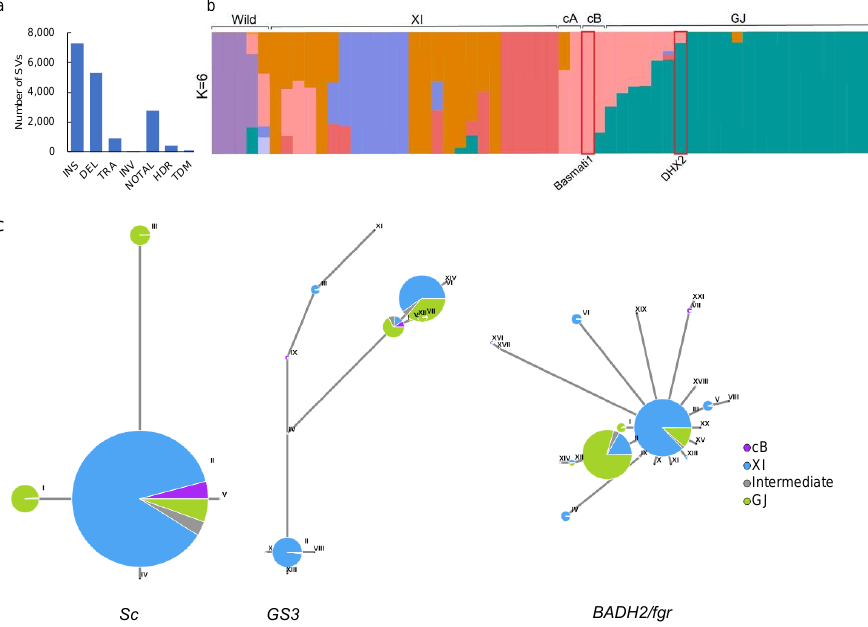
Figure 4. The population structure analysis of 58 assemblies. ( a ) The different types of SVs between DHX2 and Nip. INS: insertion, DEL: deletion, TRA: translocation, INV: inversion, NOTAL: not aligned region, TDM: tandem repeat, HDR: highly diverged regions; ( b ) Structure analysis of 58 accessions with different numbers of clusters, K = 6. The different colors represent different groups of rice accessions. ( c ) Haplotype network of Sc , GS3 , and BADH2 / fgr using sequence data of the 3000 Rice Genomes Project. Circle size is proportional to the sample number for a given haplotype. Different colors represent ecotypes, as shown in the illustration. Different Roman numerals indicate various haplotypes of Sc , GS3 , and BADH2 / fgr .